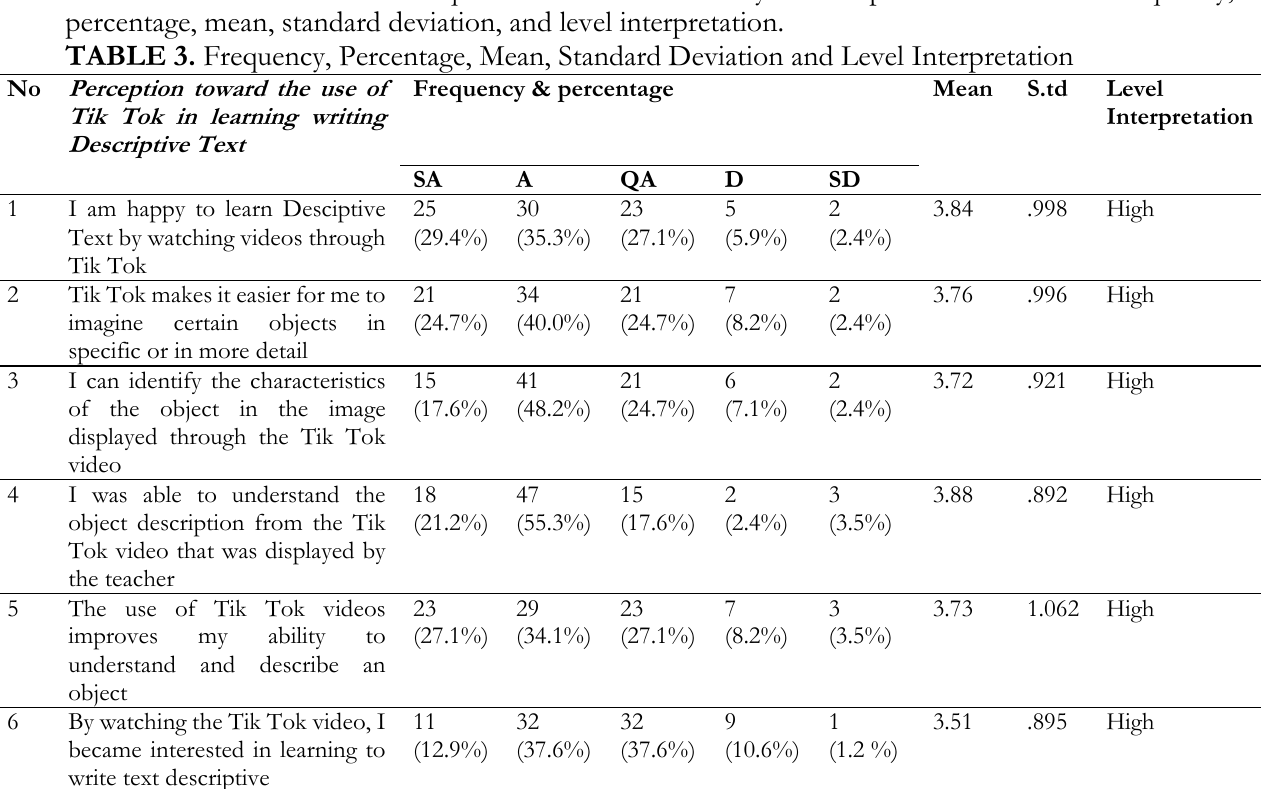
TABLE 3. Frequency, Percentage, Mean, Standard Deviation and Level